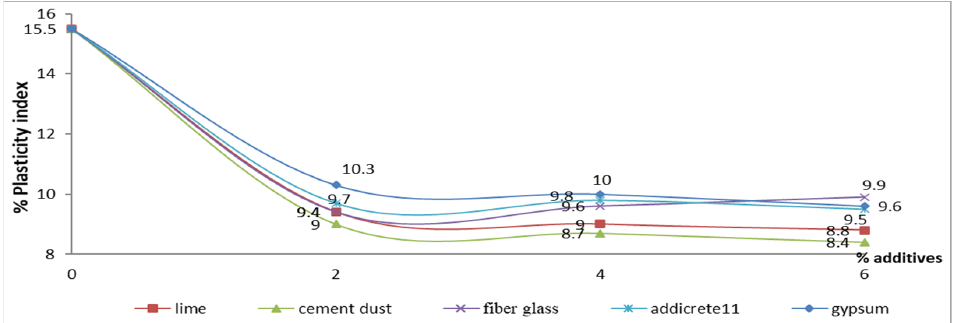
Figure 18. Effect of additives on plasticity index.